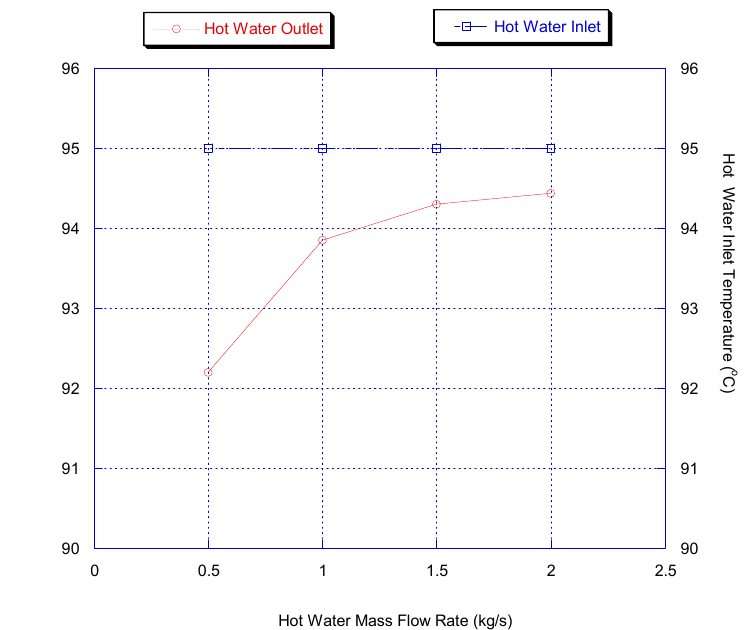
Figure 9. Effect of hot water flow rate on hot water outlet temperature (results are at chiller nominal operating conditions, shown in Appendix B).